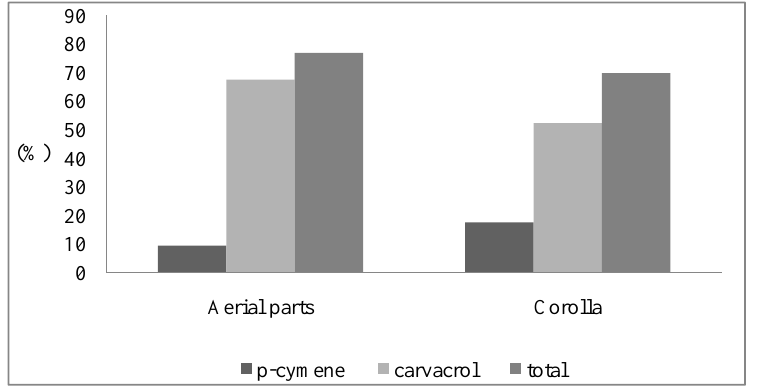
2 - β -Pinene, 1-octen-3-ol, α - thujone, dihydrocarvone, thymol, δ -cadinene, and